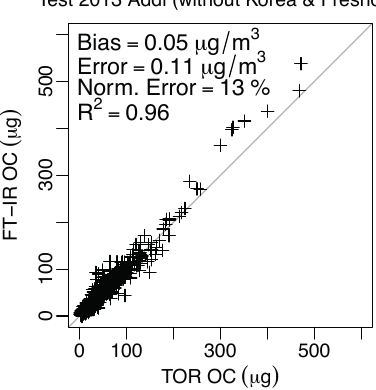
Figure 6. Scatter plot and performance metrics between FT-IR OC and TOR OC for the Test 2013 Addl data sets (Sect. 2.1) without the ambient samples collected at Fresno and Korean sites. Concentra- tion units of µgm − 3 for bias and error are based on the IMPROVE nominal volume of 32.8m 3